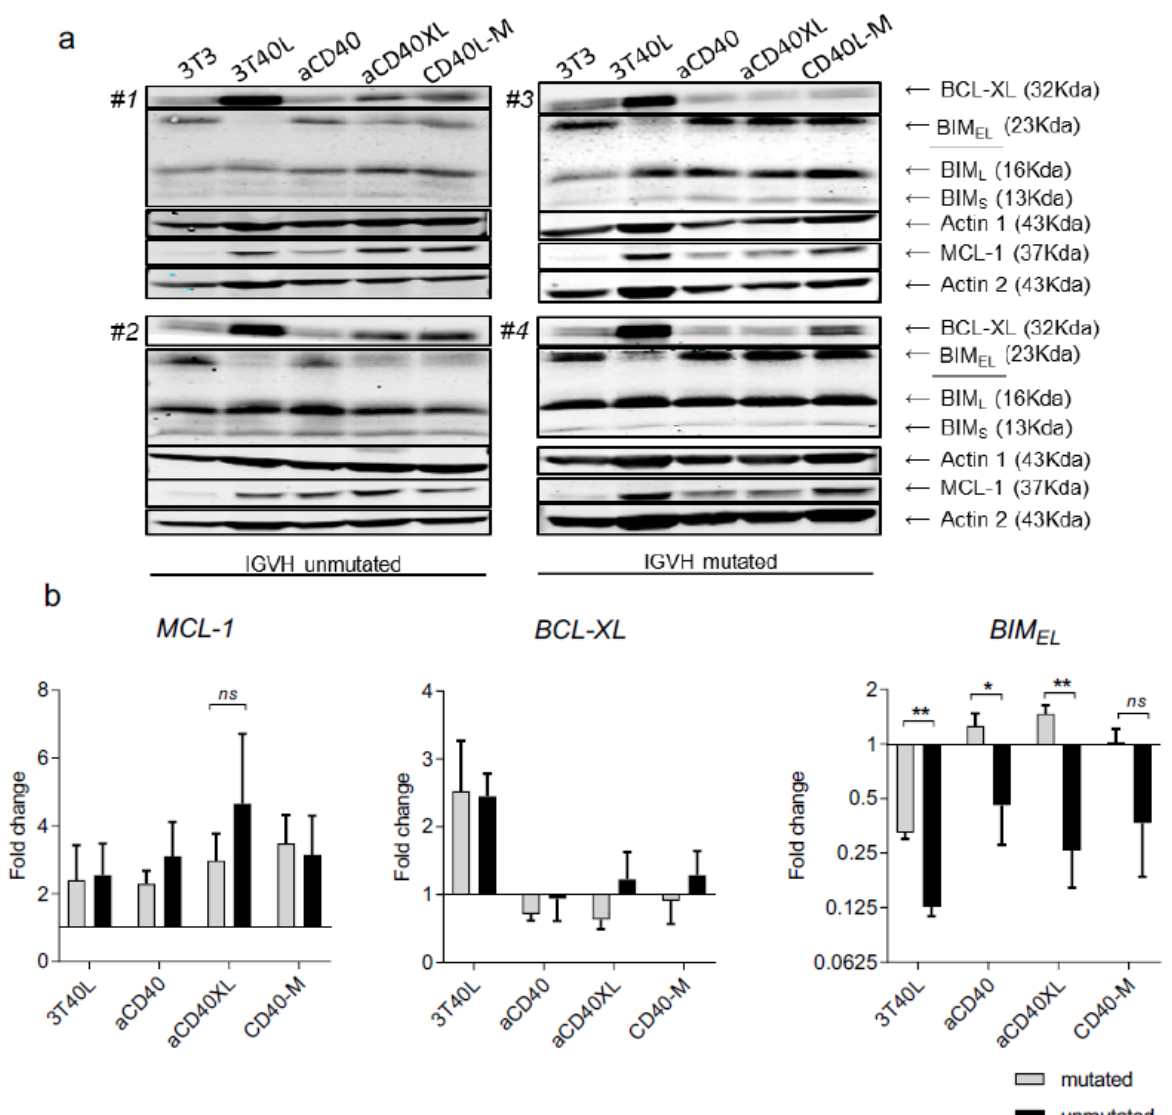
Figure 3. Regulation of BCL-2 family upon distinct modes of CD40 stimulation and comparison between IgHV status of CLL patients. A,B CLL cells were cultured and CD40-stimulated as previously described for 48 h. ( a ) Protein lysates were probed for BCL-XL, BIM (EL, L, S) and MCL-1 and actin as loading control. Results from a representative CLL sample of 8 patients ( n = 6 for BIM EL ). ( b ) Protein quantification measured by background method (Odyssey V3.0) and normalized with actin shows differences between IGHV-mutated and unmutated patients. Fold change is relative to unstimulated CLL cells (3T3). Bars represent the mean ± SEM: * p < 0.05, ** p < 0.01 (unpaired t -test).